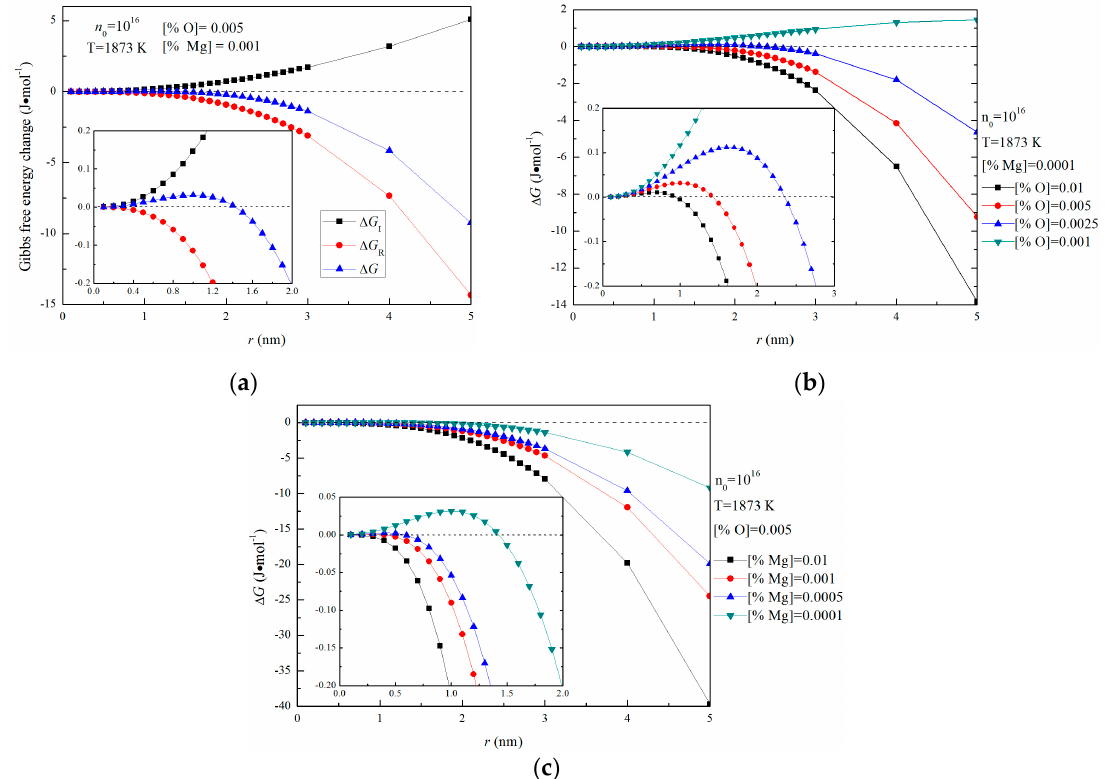
Figure 5. Gibbs free energy changes for the formation of magnesia with n 0 = 10 16 in Fe-O-Mg melt, ( a ) ∆ G I , ∆ G R and ∆ G M for [%Mg] = 0.001 and [%O] = 0.005, ( b ) Gibbs free energy changes for various initial magnesium contents ([%O] = 0.01, 0.005, 0.0025 and 0.001) and 0.0001 mass pct Mg, ( c ) Gibbs free energy changes for various initial magnesium contents ([%Mg] = 0.01, 0.001, 0.0005 and 0.0001) and 0.005 mass pct O.